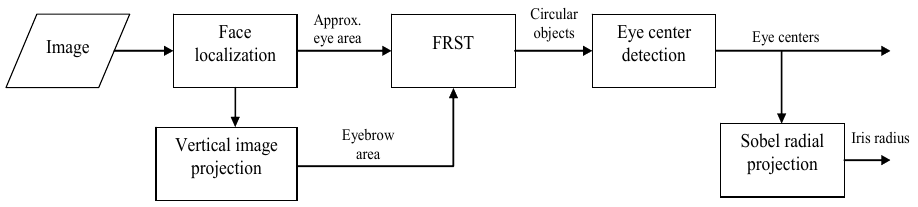
Figure 1. Iris segmentation algorithm.